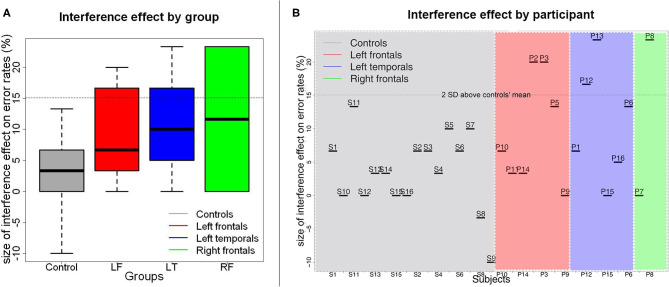
Size of the proactive interference effect on error rates by patient group (A) and by participant (B). In (A), medians are indicated by the black horizontal lines in the box-and-whisker plots. Interquartile ranges are represented by the boxes and the total range is depicted by the dotted lines. The horizontal dotted line indicates the value corresponding to the controls' mean interference effect size plus 2 standard deviations above the controls' mean. As can be seen in (B), a few participants from each patient group had interference effects that were larger than this value.